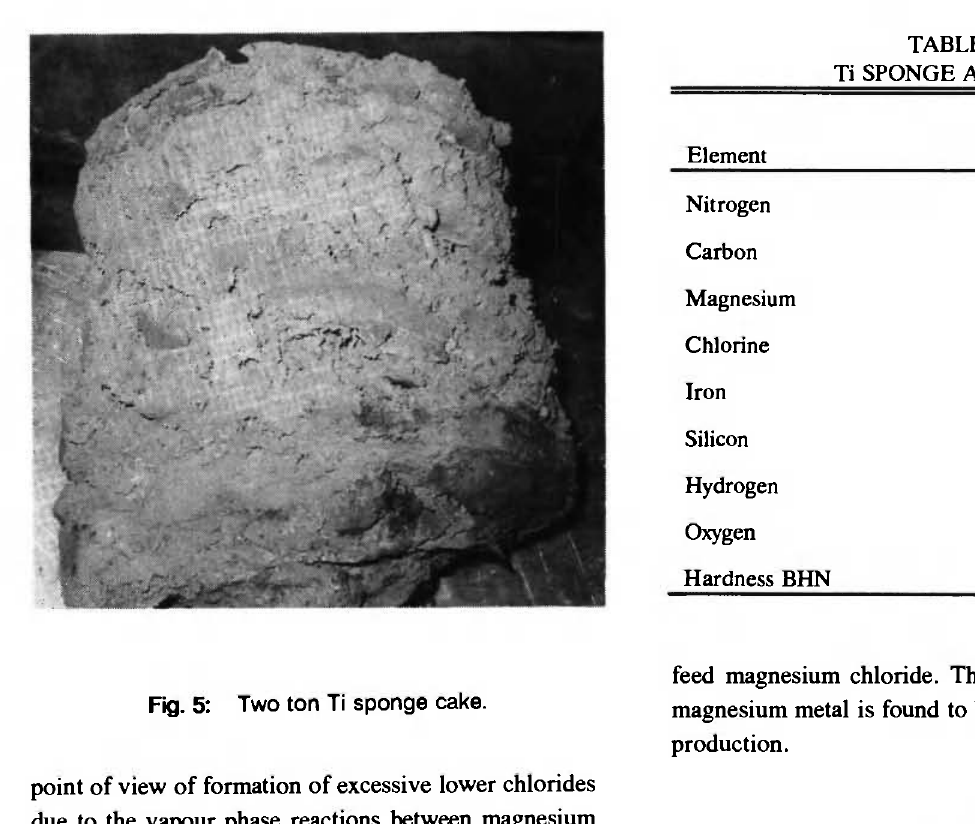
Two ton Ti sponge